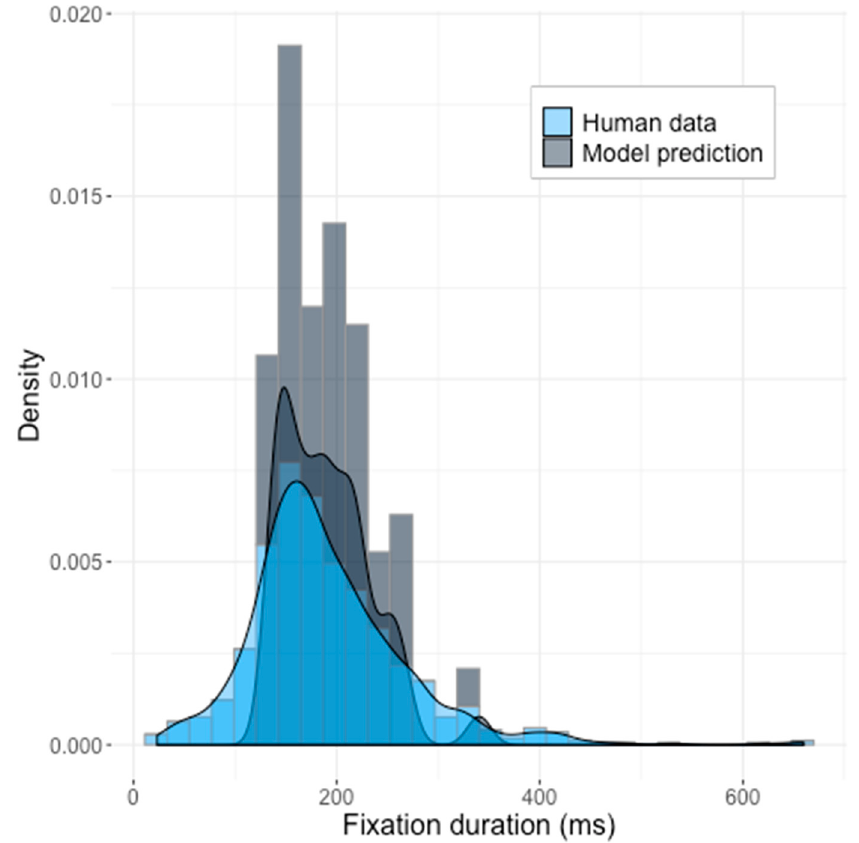
Figure 6. The Saliency Model’s predictions with the third set of parameters shown against the human data. The model generated ten initial saccades per image (for 44 pictures).